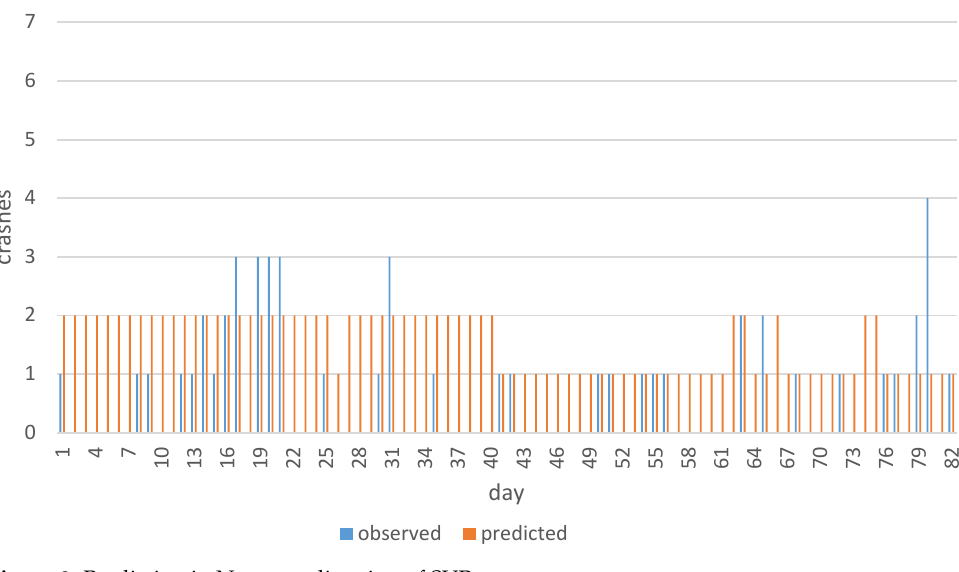
Figure 9. Prediction in Nantung direction of Figure 11. Prediction in Nantung direction of SVR.